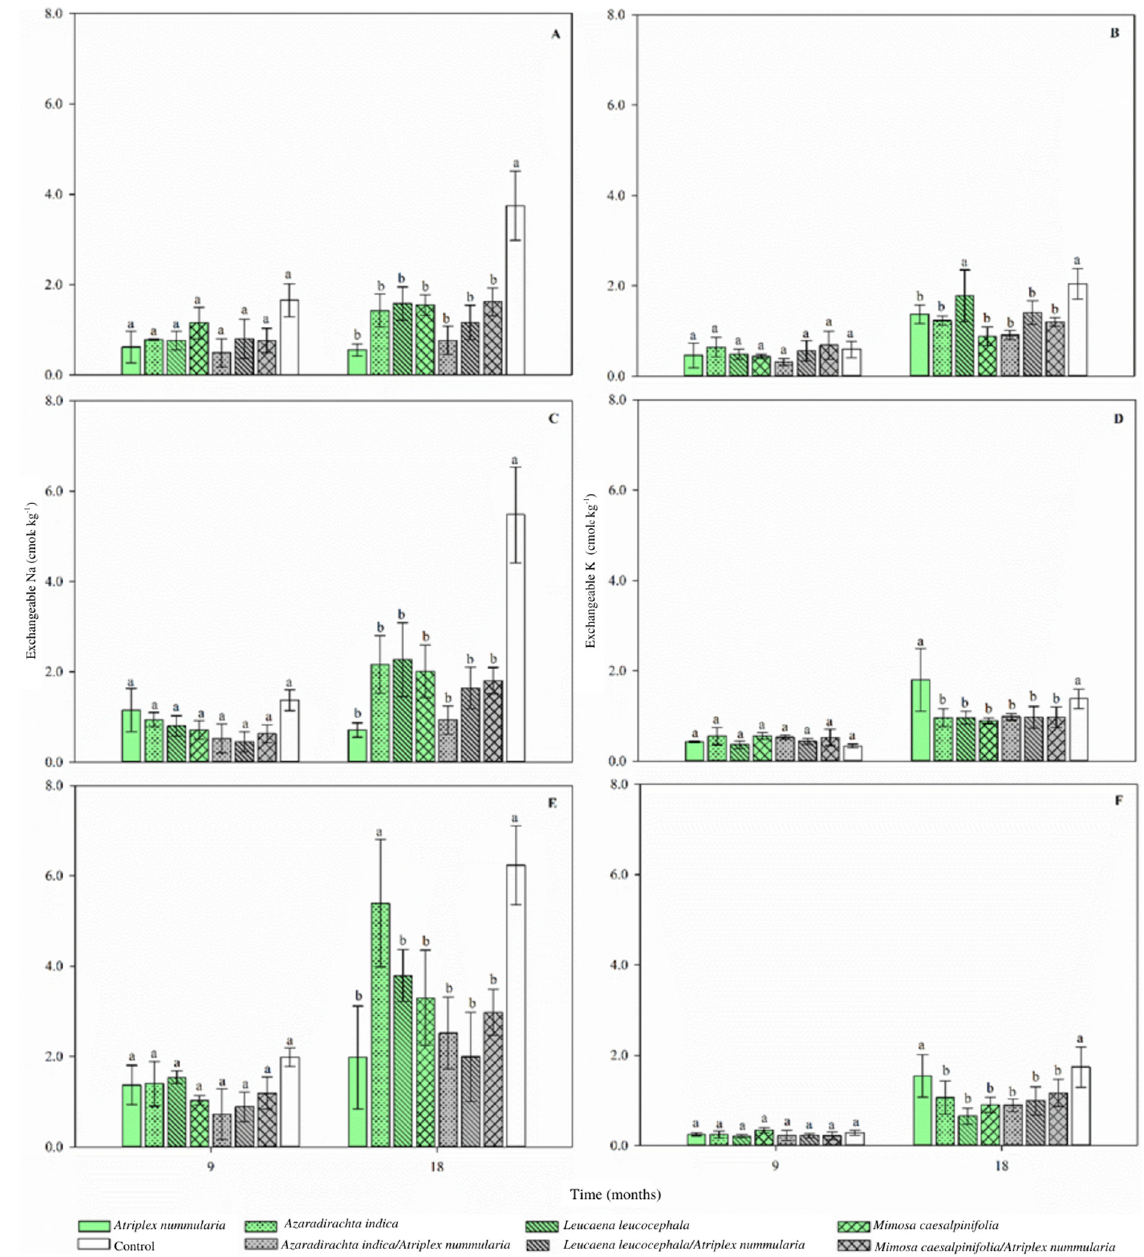
Figure 2. Exchangeable Na + [( A ) 0–10 cm; ( C ) 10–30 cm; ( E ) 30–60 cm] and K + [( B ) 0–10 cm; ( D ) 10– 30 cm; ( F ) 30–60 cm] at 9 and 18 months as result of the applied treatments (Averages of four replications). Averages followed by the same letter have no difference in the same layer and time of sampling by the Skott-Knott test ( p ≤ 0.05).